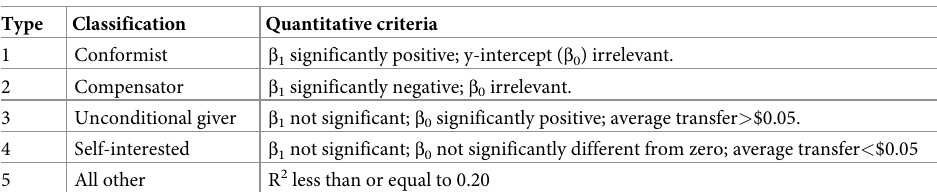
Table 2. Classification